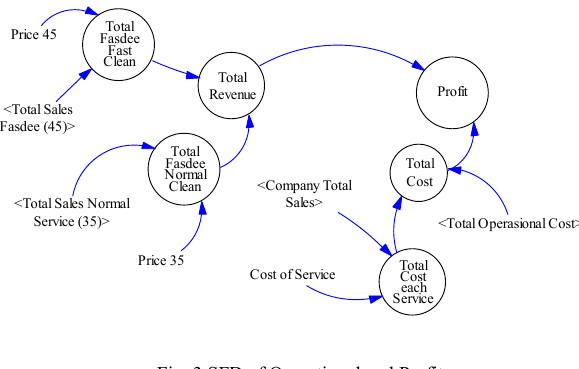
Fig. 3 SFD of Operational and